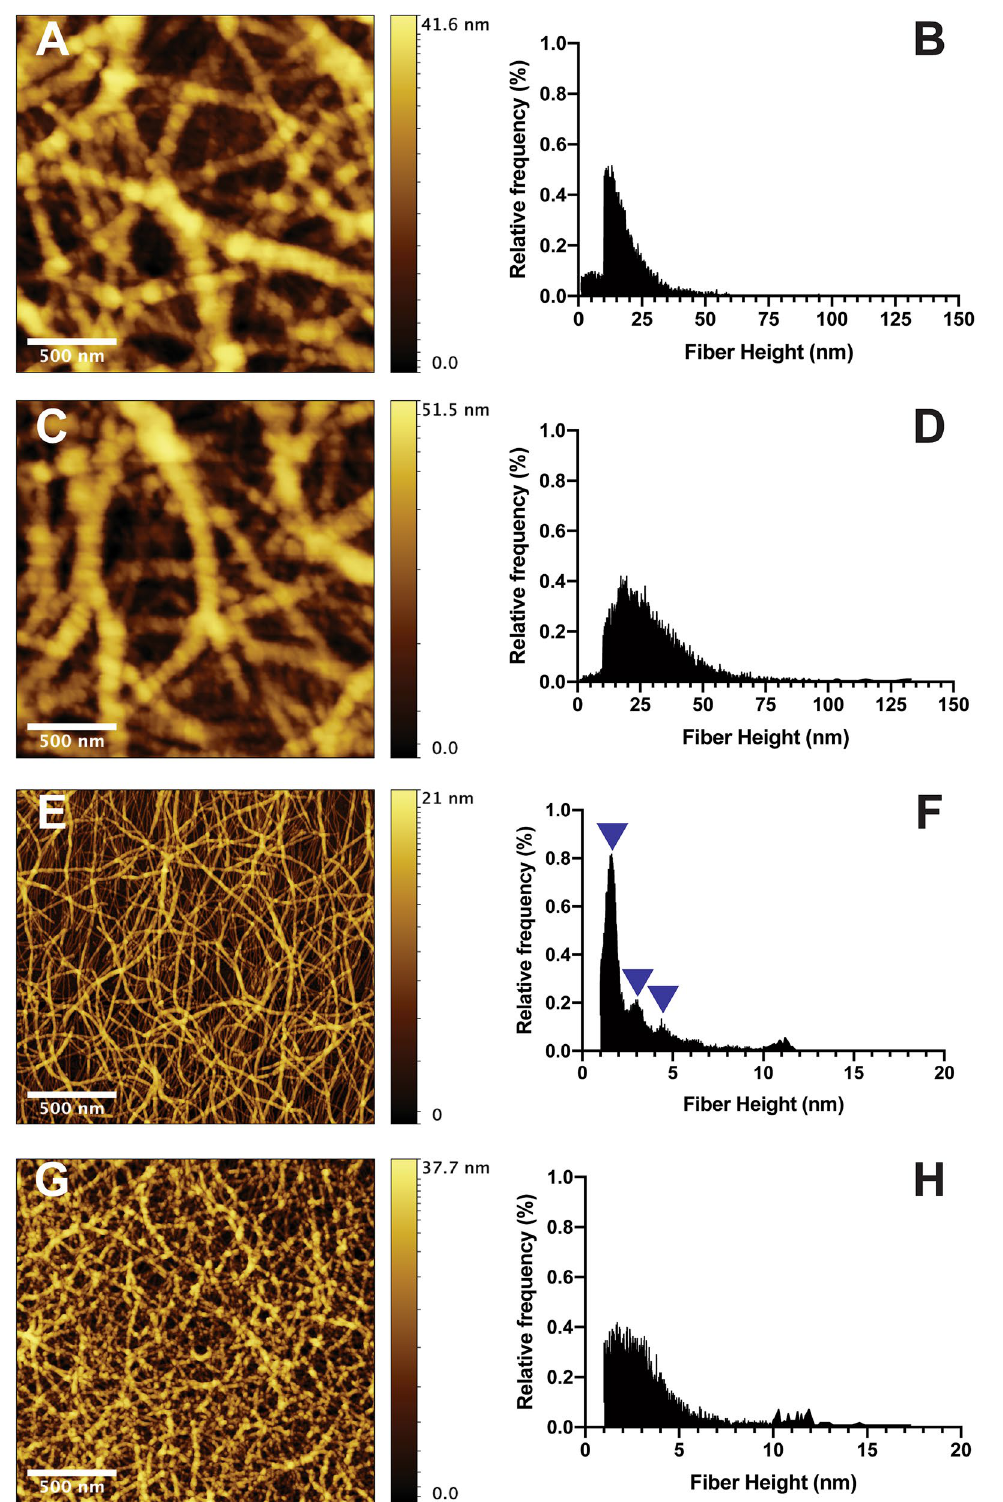
Figure 2. High-resolution atomic force microscopy (AFM) and quantitative fiber height distribution: ( A , B ) fibrin hydrogels without COAM, ( C , D ) fibrin hydrogels with COAM, ( E , F ) SAP hydrogels without COAM and with distinct peaks indicated by blue arrowheads, and ( G , H ) SAP hydrogels with